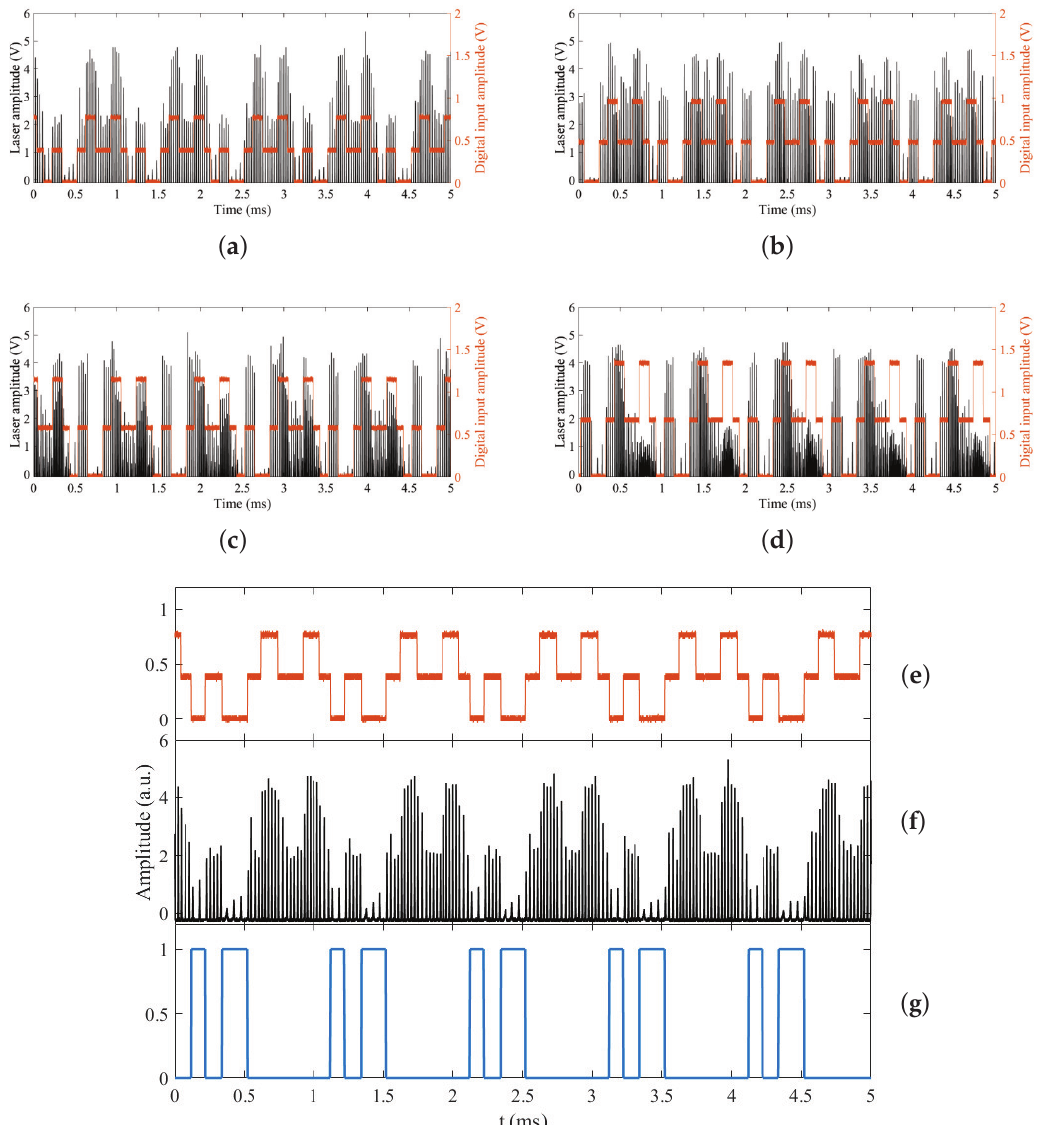
Figure 7. ( a – e ) Behavior of the laser intensity (solid black line) at f m = 40 kHz when bias I d (orange line) is added to the laser modulation. The amplitude of the digital inputs is A d = ( a ) 0.4 V, ( b ) 0.5 V, ( c ) 0.6 V, ( d ) 0.7 V, and ( e ) Digital input signal I d for A d = 0.8 V, while ( f ) shows the EDFL behavior and ( g ) represents the output of the logic gate, which is determined when P 2 is taken as logic 1 and the response in P 1 is taken as logic